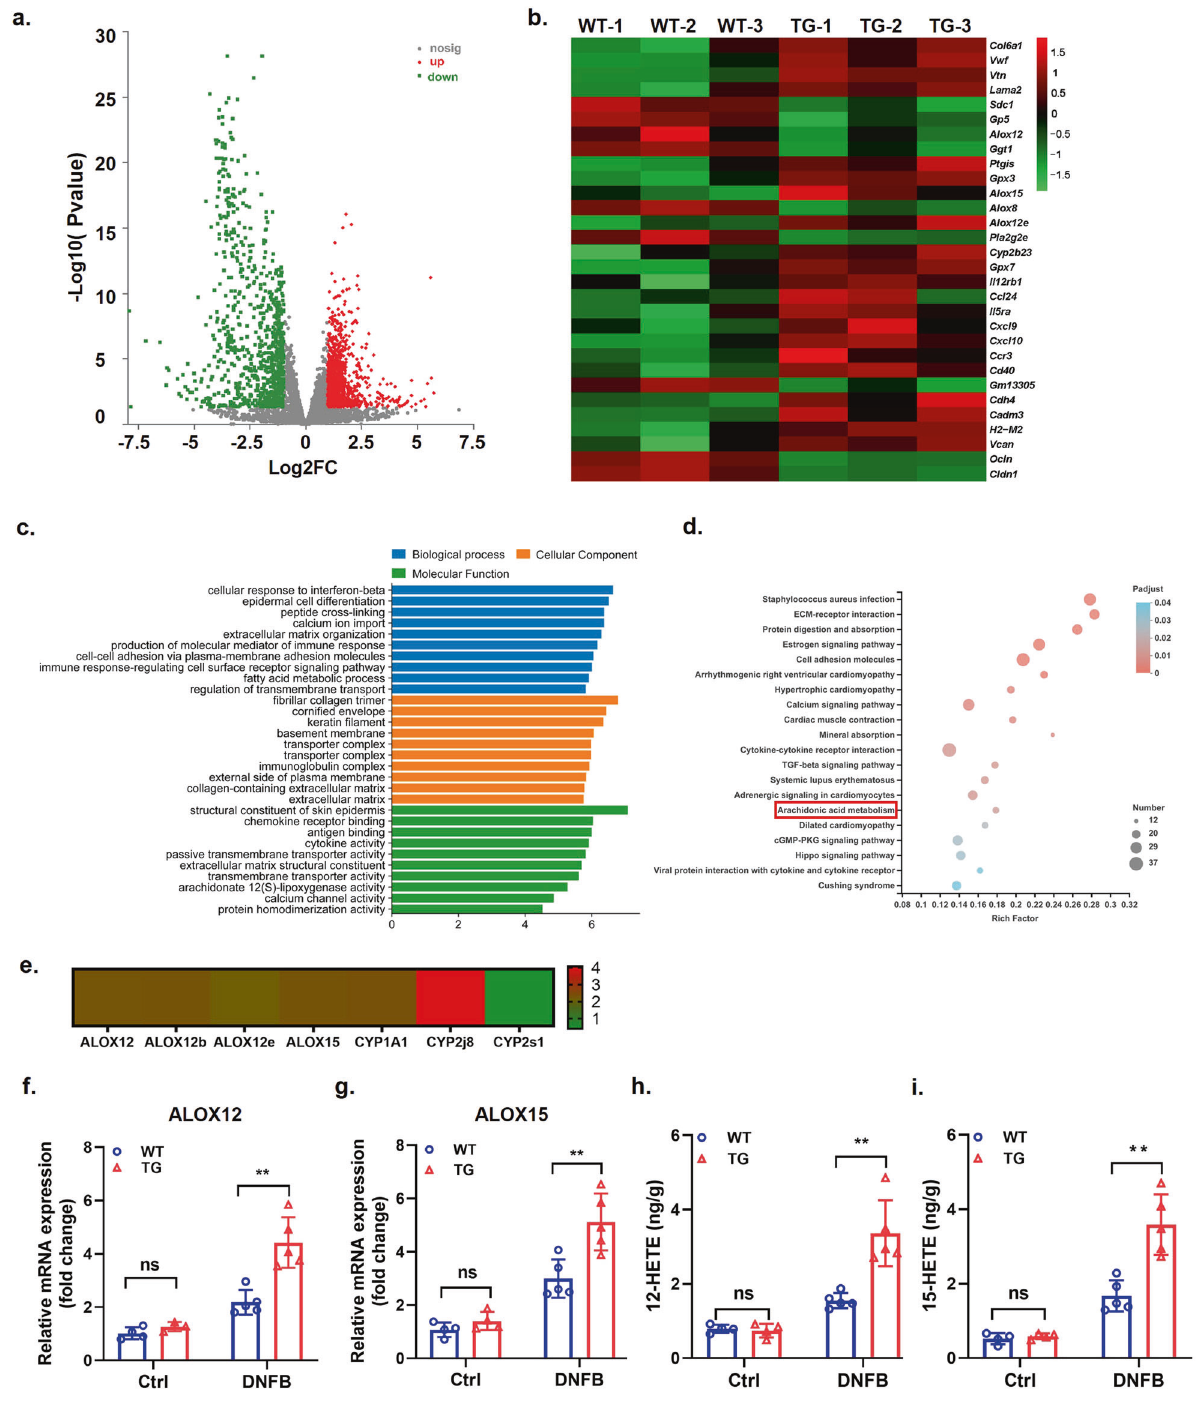
Fig. 6 WFDC12-overexpressing regulates the metabolic pathways of arachidonic acid lipoxygenase in the epidermis of modeled mice. a Volcano map of DEGs in WT-DNFB/ TG-DNFB. DEGs were more than 2 times and FDR ≤ 0.05. The abscissa represents the fold change of gene expression in each group. The ordinate represents the statistical difference in gene expression. Red dots and blue dots represent upregulated genes and downregulated genes in WT-DNFB/ TG-DNFB, respectively. Gray dots indicate the indifference genes. b Heatmaps showing the representative 30 DEGs in WT-DNFB/ TG-DNFB. c DEGs in TG-DNFB and WT-DNFB were clustered in the term of biological process. subcellular localization and molecular function. d KEGG Pathway enrichment analysis results. The results were arranged according to the p value from the smallest to the largest. and 10 items were selected for drawing. e The fold changes of DEGs were gathered in the AA pathway in DNFB- induced mice. f and g RT-PCR analysis of the relative expression of ALOX12 ( f ) and ALOX15 ( g ) in the epidermis of mice ( n = 4 or 5). h and i ELISA analysis of 12-HETE ( h ) and 15-HETE ( i ) in the epidermis of mice ( n = 4 or 5). Data were expressed as mean ± SD. Asterisks indicate statistical signi fi cance based on unpaired or paired T -test; ** p < 0.01. ‘ ns ’ indicates no statistical difference.